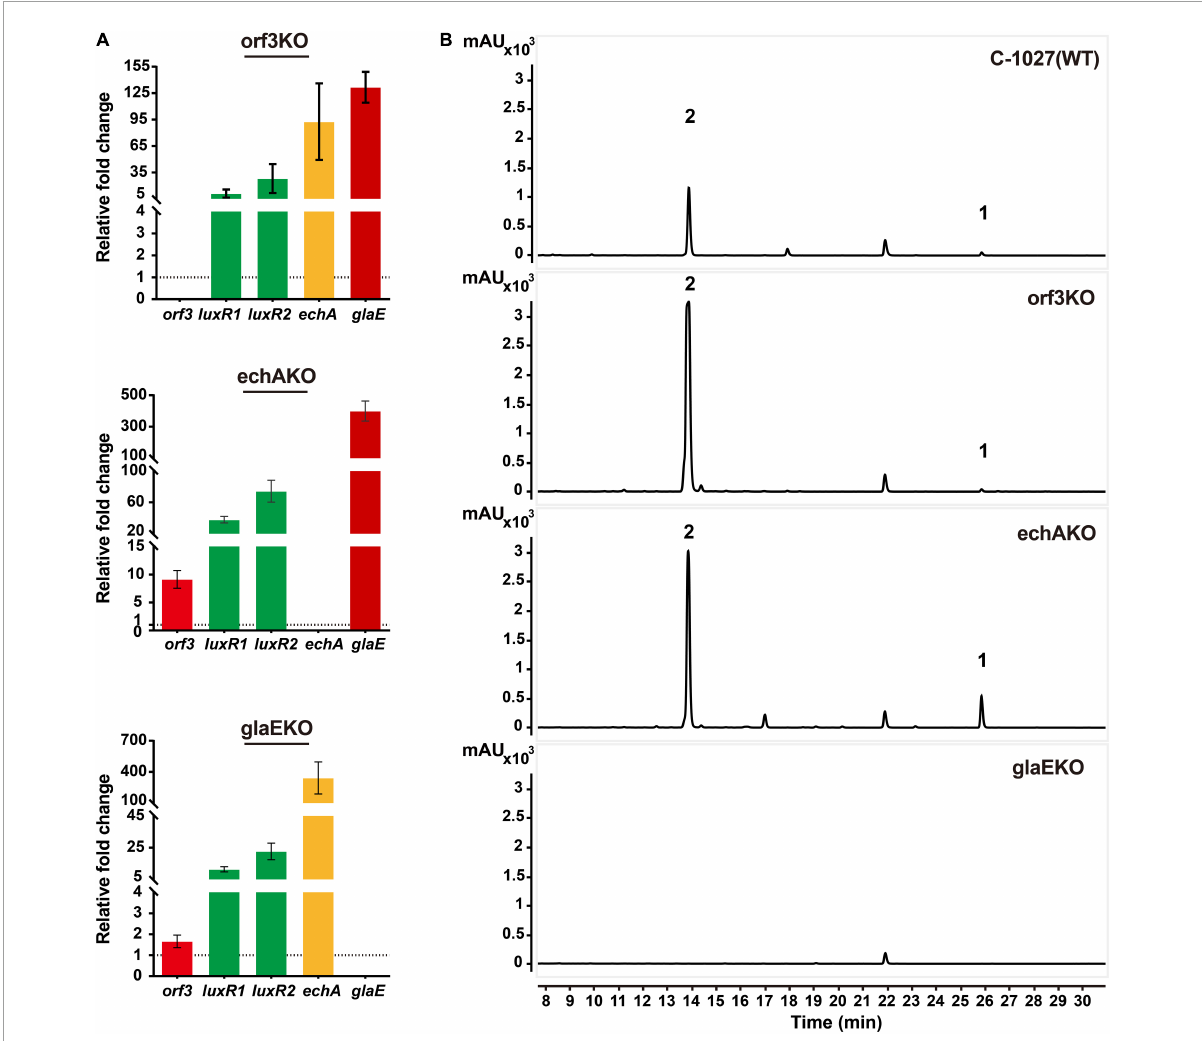
FIGURE4 Compounds 1 and 2 were the cluster-specific products of cluster 26. (A) Transcriptional analysis of knockout mutants detected by RT-qPCR analysis. The relative mRNA level of the target genes was normalized to the principal sigma factor gene hrdB . The relative expressional level of each sample was represented as the value related to the wild-type strain S. globisporus C-1027. Values are presented as means ± SEM (two biological repeats for orf3KO mutant and echAKO mutant and three biological repeats for glaEKO mutant). (B) Analysis of the metabolic profiles of knockout mutants by HPLC-MS. The production of compounds 1 and 2 was abolished when the glaE gene was inactivated in the S. globisporus